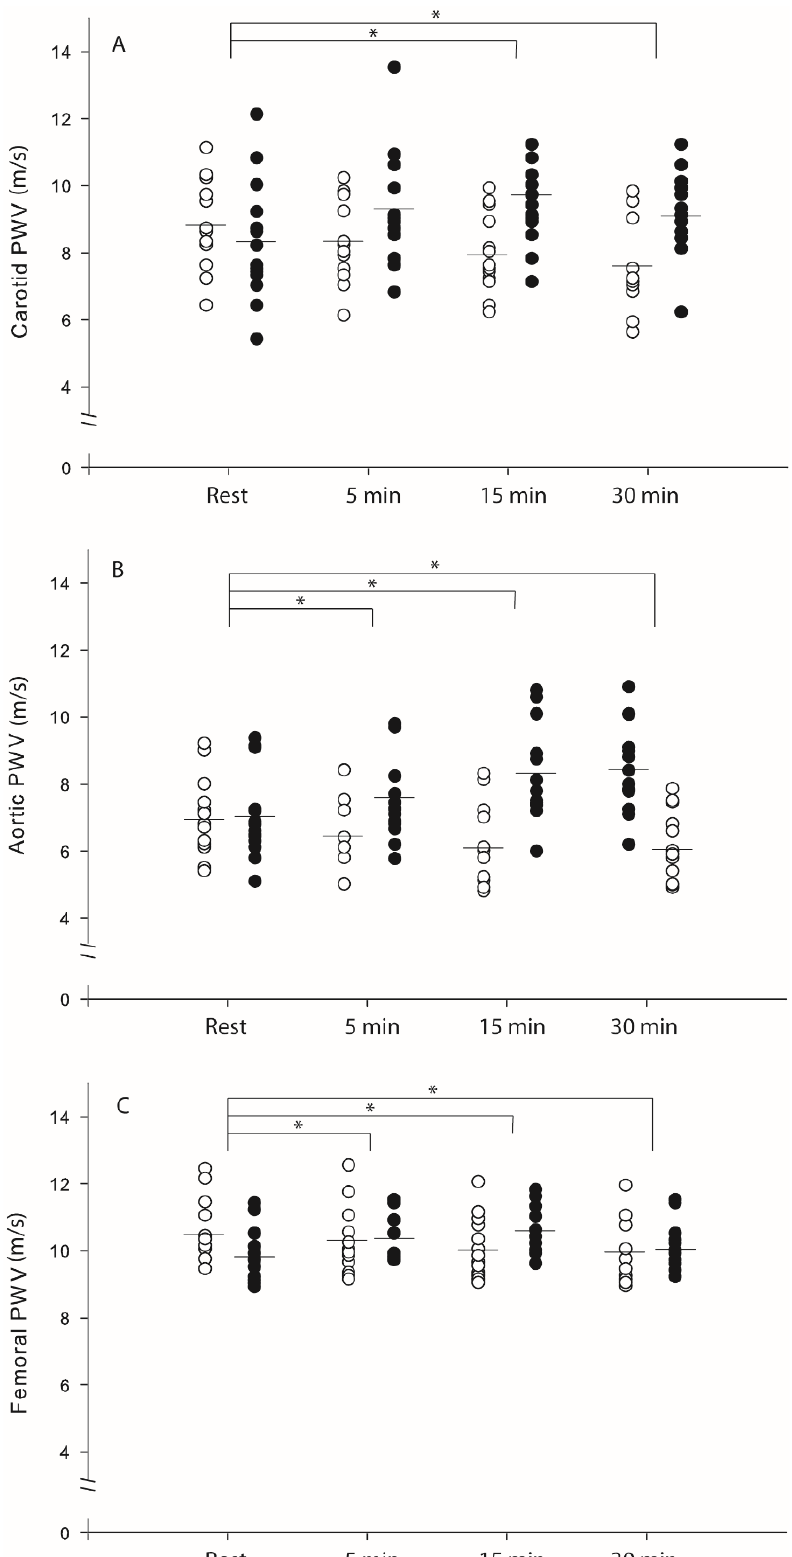
Figure 1. Carotid ( A ), aortic ( B ), and femoral ( C ) PWV at rest and throughout the post-exercise period. Data are presented as ( ) EES and ( ) RES. * Significant difference from baseline within group: p < 0.05.